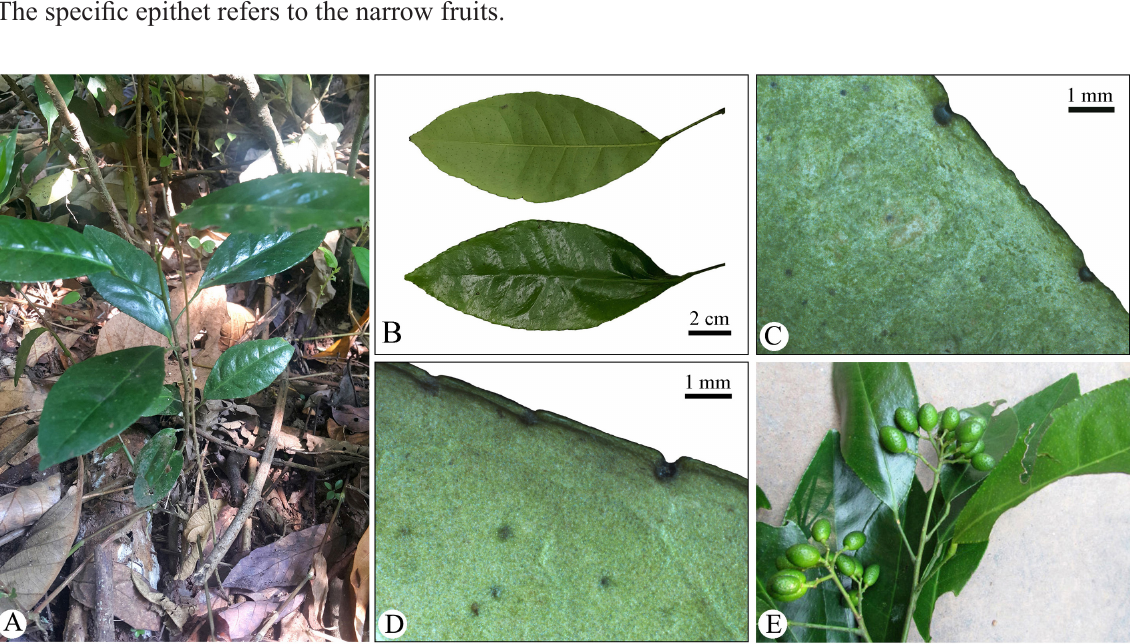
Fig. 12. Bergera stenocarpa (Drake) F.J.Mou comb. nov. A . Plant. B. Leaves. C–D . Dorsal side of leaf. E . Infructescence. Photos taken by Nguyen Manh Cuong in Vietnam and Feng-Juan